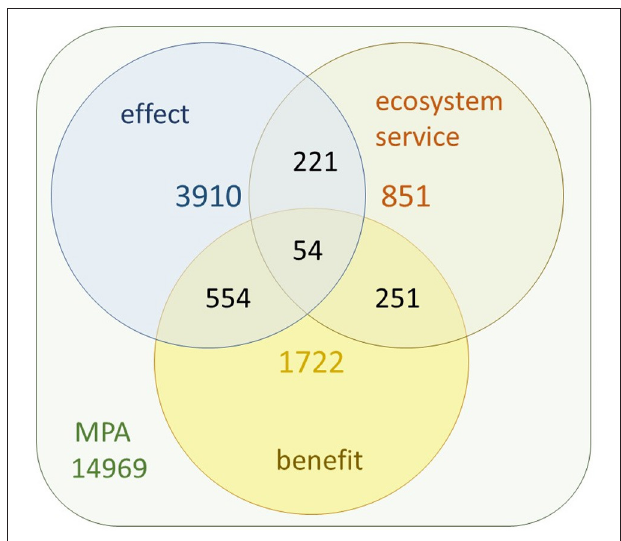
FIGURE 2 | Number of articles identified searching the concepts “marine protected area + effect,” “marine protected area + ecosystem service,” and “marine protected area + benefit” and their respective intersections in the TOPIC field of the Web of Science database.